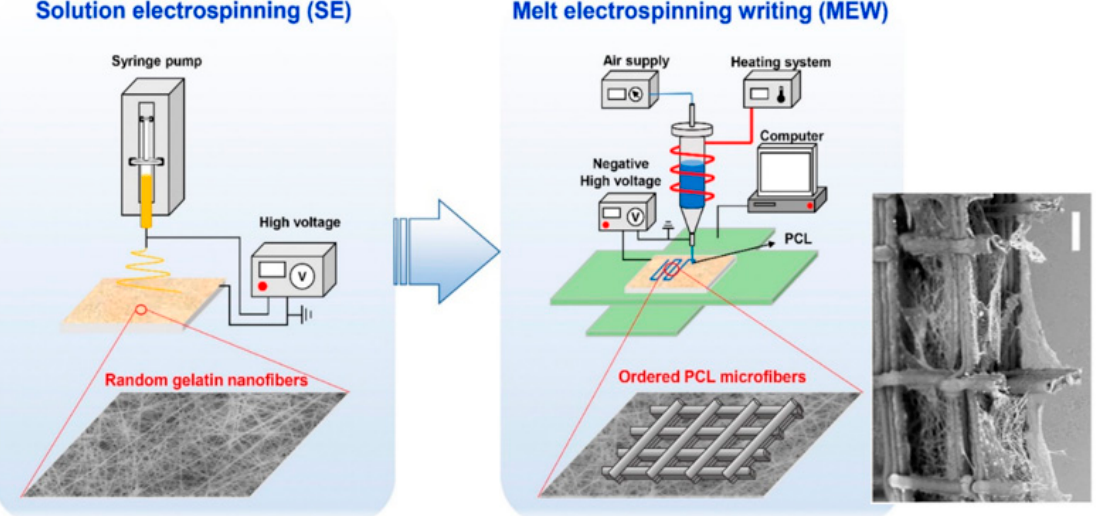
Figure 18. Scheme showing the fabrication of hierarchical structures by combining MEW and conventional electrospinning techniques. The inset shows an SEM image of the multi-layered scaffold (scale bar corresponds to 40 μ m). Reproduced with permission from [287].